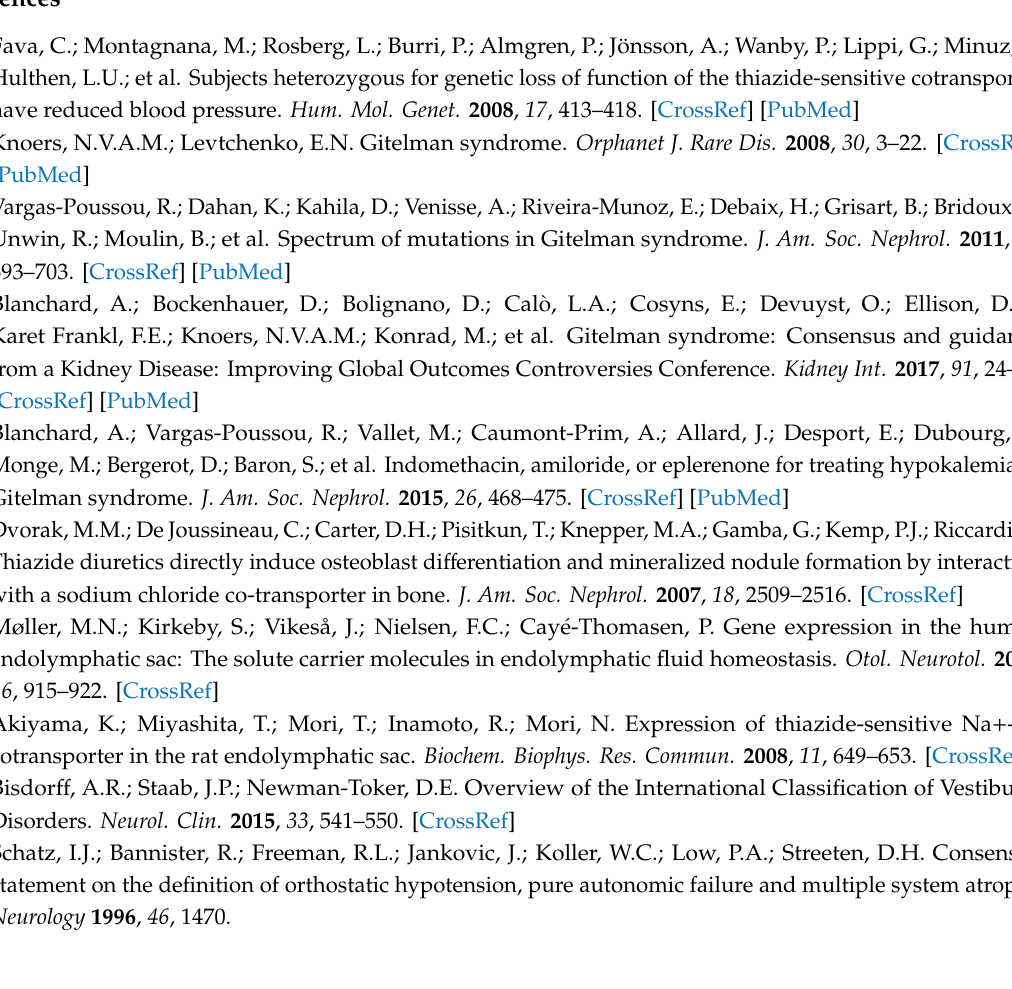
Table S1. Responses of the Gitelman patients to the survey on vertigo clinical presentation. Table S2. Variants detected in Gitelman syndrome patients in the SLC12A3 gene and their classification. Table S3. Baseline characteristics and treatment of the 16 Gitelman syndrome patients with vertigo. Table S4. Comparative biological and clinical results between patients with normal and abnormal vestibular function. Figure S1. Ion exchanges in the endolymphatic sac. Figure S2. Clinical set up and principle of the video head impulse test (VHIT). Figure S3. Normal result to video head impulse test (VHIT). Figure S4. Clinical set up and principle of kinetic tests. Figure S5. Clinical set up and principle of caloric